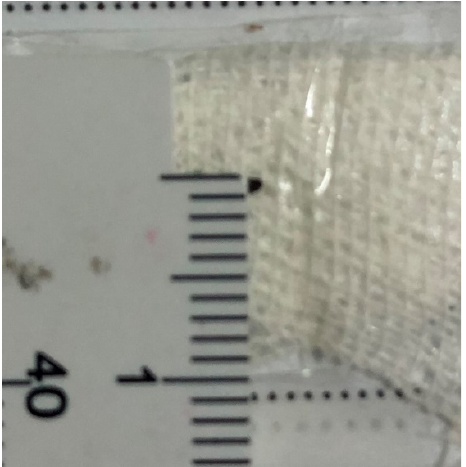
Figure 1. Small IOFB (1 mm). IOFB=Intraocular foreign body.